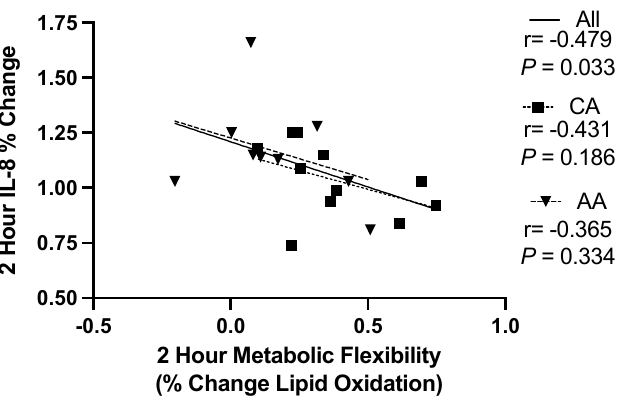
Figure 3. Baseline and postprandial IL-8 response to a high-fat meal in African American and Caucasian American females (ANOVA: Time, p = 0.039, η p2 = 0.277; Group, p = 0.050, η p2 = 0.259; n = 23). * p ≤ 0.05 between CA vs. AA females. * p ≤ 0.05 between AA and CA, a p ≤ 0.05 compared to baseline for AA females. AA—African American; CA—Caucasian American.